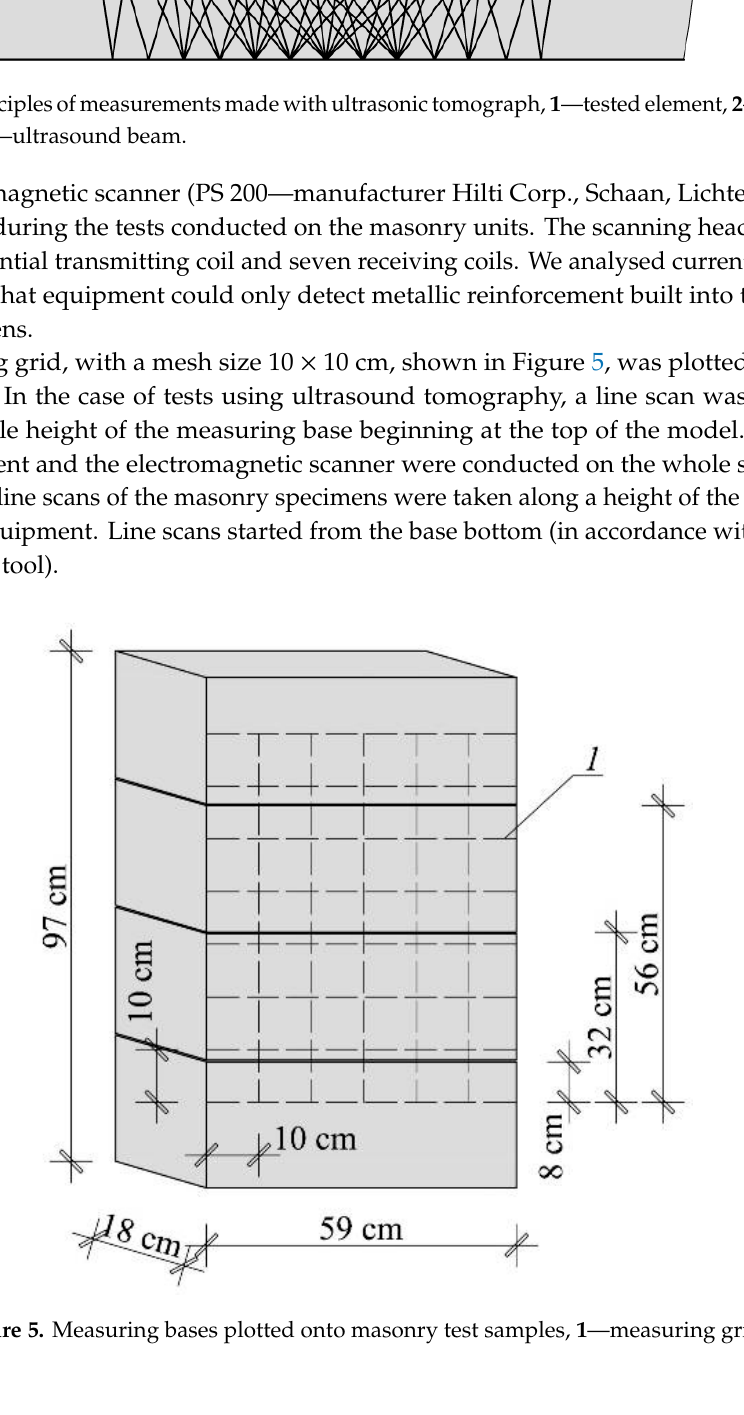
Figure4. Principlesof measurements madewithultrasonic tomograph, 1 —testedelement, 2 —ultrasonic Figure 4. Principles of measurements made with ultrasonic tomograph, 1 — tested element, 2 — ultrasonic transducer, 3 —ultrasound beam. transducer, 3 —ultrasound beam.